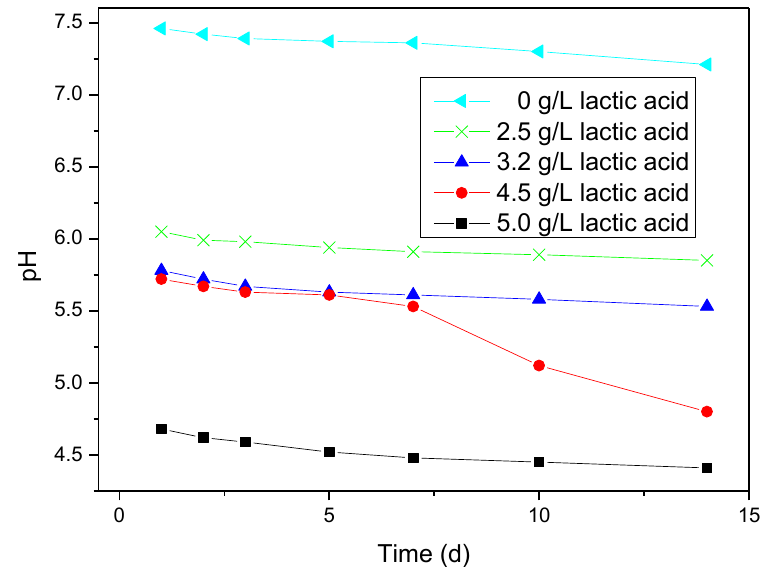
Figure 1. pH values of artificial saliva containing a working electrode with and without lactic acid for different